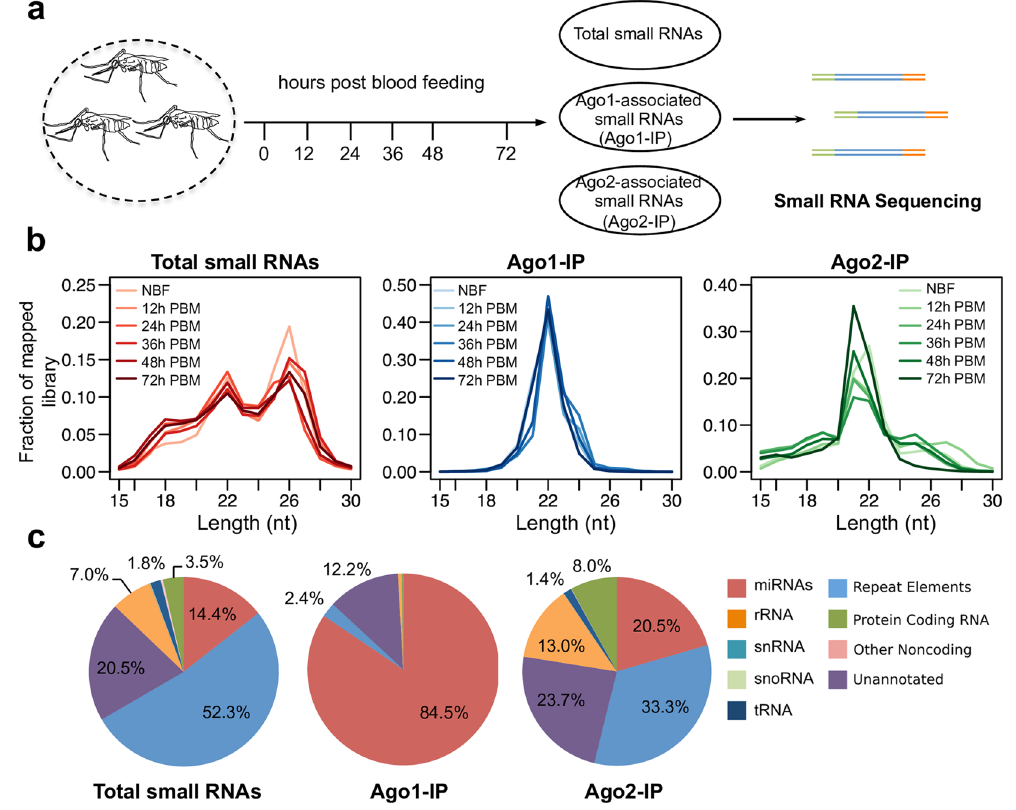
Figure 1. Sequencing of An . gambiae small RNAs. ( a ) Schematic of small RNA library preparation. Adult abdomens were dissected from female An . gambiae at the indicated time points. Three types of RNA pools (Total, Ago1-IP and Ago2-IP) were prepared independently. Small RNAs of 15–30 nt were size-selected from 10% TBE-urea gels and purified for library construction. ( b ) Length distribution of total sequencing reads. NBF, non-blood-fed; PBM, post-blood meal. ( c ) Annotation of sequencing reads. Reads from the same type of RNA libraries were put together for comparison. Minor fractions (less than 1%) are not labeled.